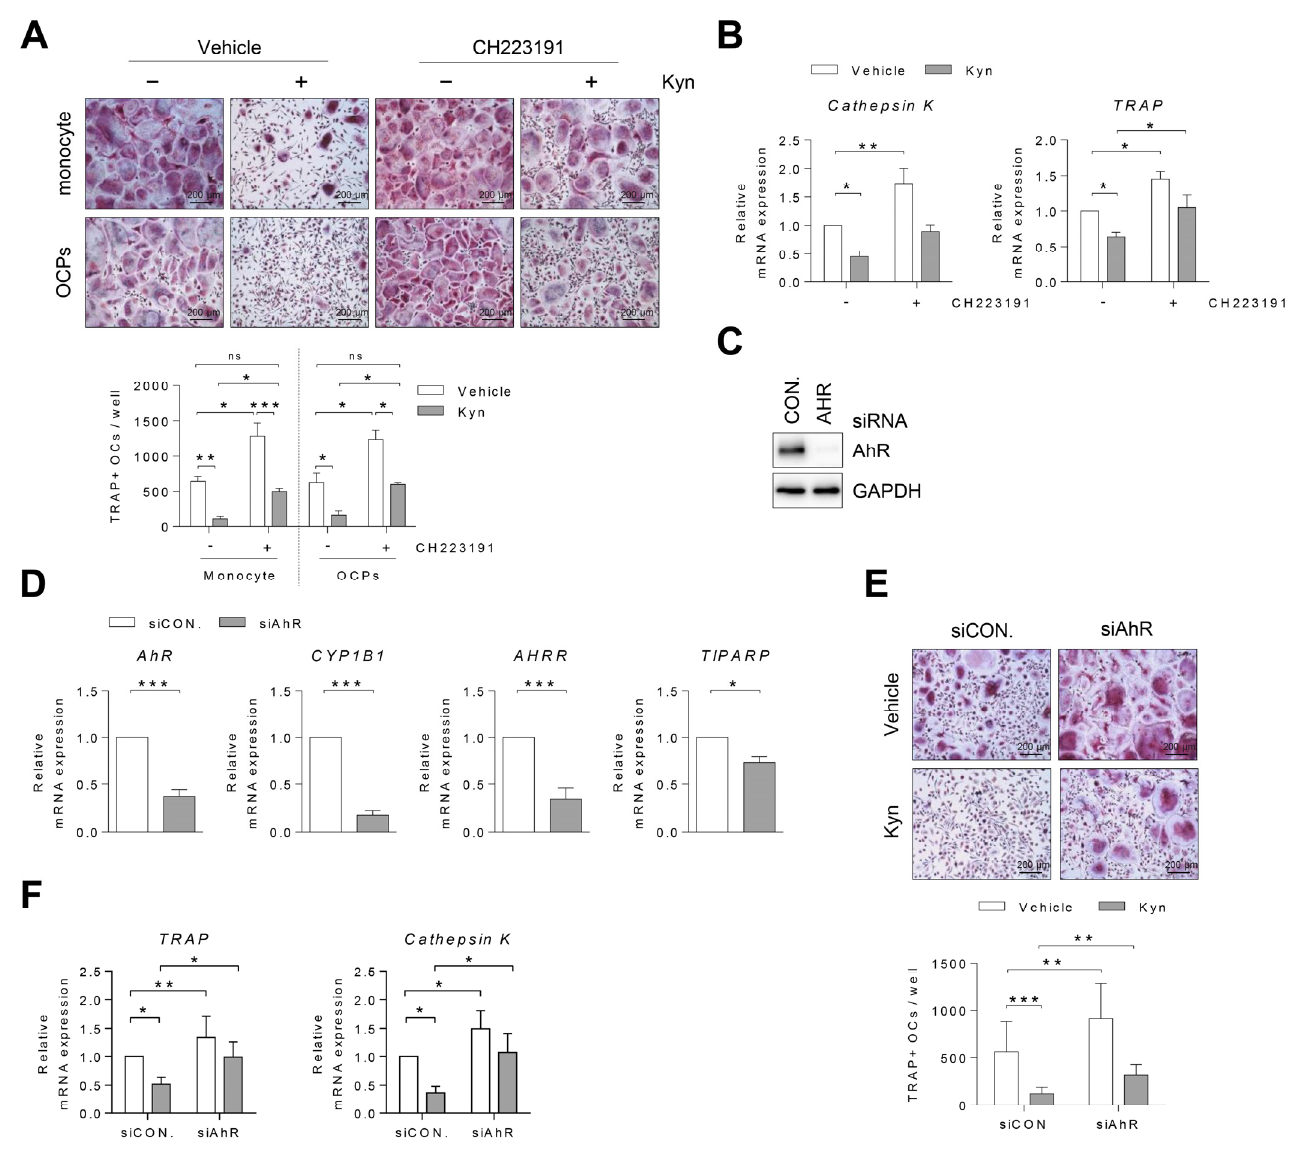
Figure 4. Blockade of AhR signaling reverses Kyn-induced inhibition of osteoclast differentiation. ( A ) Human PBMC CD14+ cells (monocytes) or OCPs were pretreated with CH223191 (5 µ M) for 3 h and then cultured with Kyn (100 µ M) under osteoclast differentiation conditions. On day 8, the cells were stained with TRAP and the TRAP+ osteoclasts were counted. ( B ) Mature osteoclast markers of Cathepsin K and TRAP mRNA expression were measured using RT-qPCR and then normalized to that of GAPDH . ( C , D ) Human PBMC CD14+ cells were treated with M-CSF (40 ng/mL) for 3 days, and then transfected with siRNA against control (siCON.) or AhR (siAhR) for 24 h. ( C ) Level of AhR protein was detected by immunoblotting. ( D ) AhR-induced genes of CYP1B1 , AHRR , and TIPARP were analyzed using RT-qPCR and normalized to that of GAPDH . ( E , F ) After transfection, the cells were cultured with Kyn (100 μ M) in the presence of M-CSF (40 ng/mL) and RANKL (80 ng/mL) for 7 days. ( E ) The cells were stained with TRAP on day 7, and the TRAP+ osteoclasts were counted. ( F ) Mature osteoclast markers of Cathepsin K and TRAP mRNA expression were measured using RT-qPCR and normalized to that of GAPDH . Images were taken at original magnification 100×. Scale bar is 200 μ m. Data are shown as mean ± SD of more than three independent experiments and a two-way ANOVA test was applied. * p < 0.05, ** p < 0.01, *** p < 0.001, ns p > 0.05.